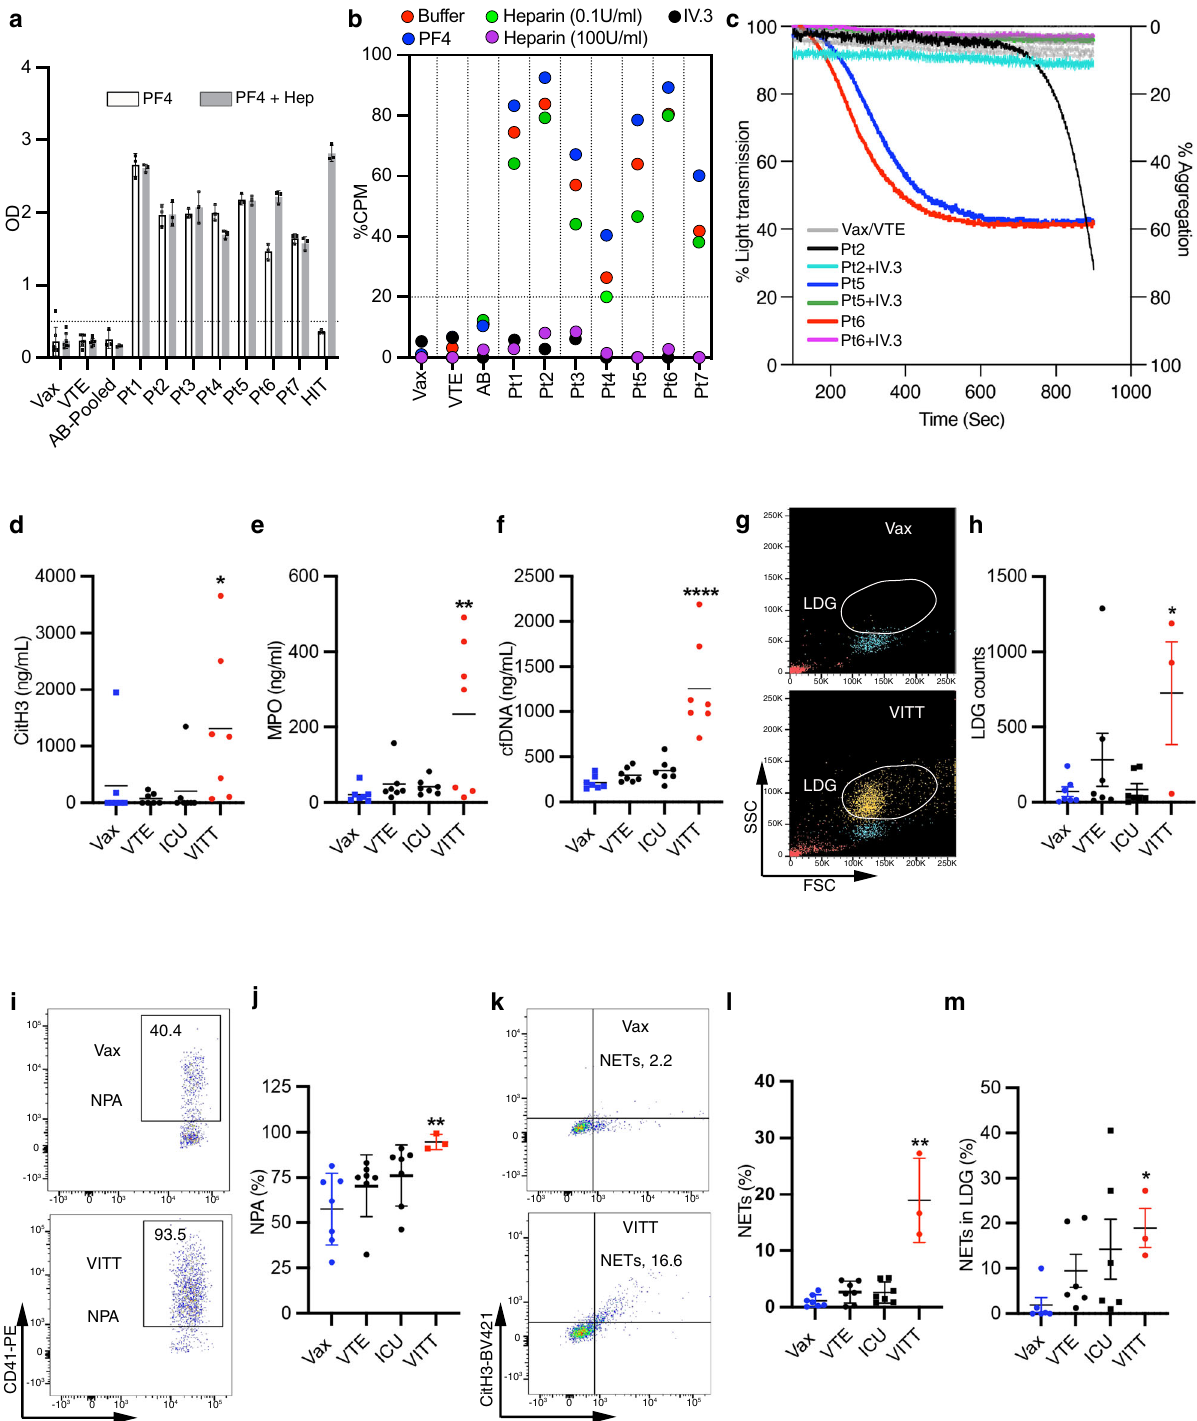
NETosis in vitro. To con fi rm the role of Fc γ RIIa and NETosis in VITT- induced thrombosis, blood was pre-treated with anti-Fc γ RIIa mono- clonal antibody, IV.3 or DNase I prior to incubation with VITT IgG. There was no induction of NETosis as indicated by the absence of DNA release in the presence of IV.3 (Fig. 2g, h). Furthermore, IV.3